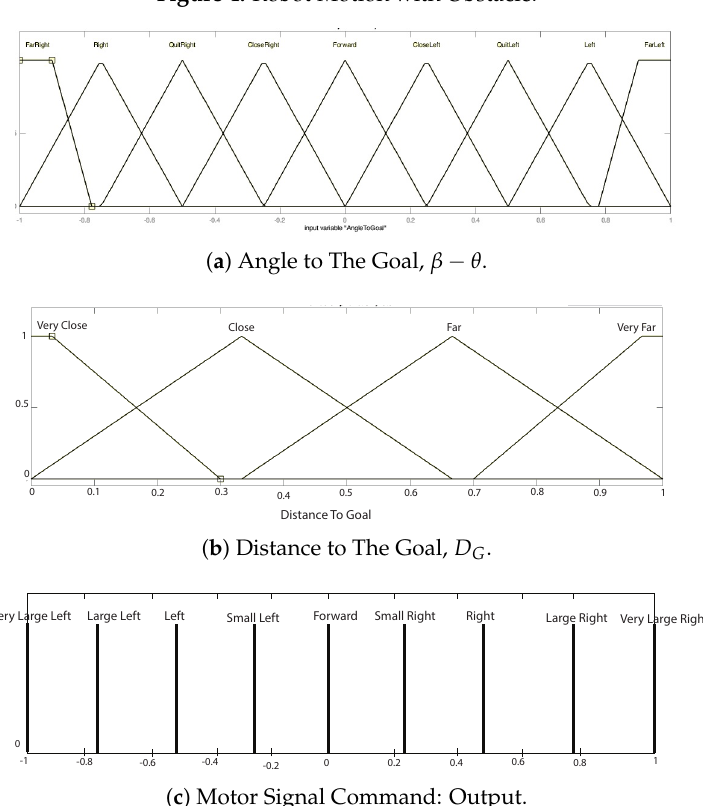
Figure 4. Robot Motion with Obstacle.